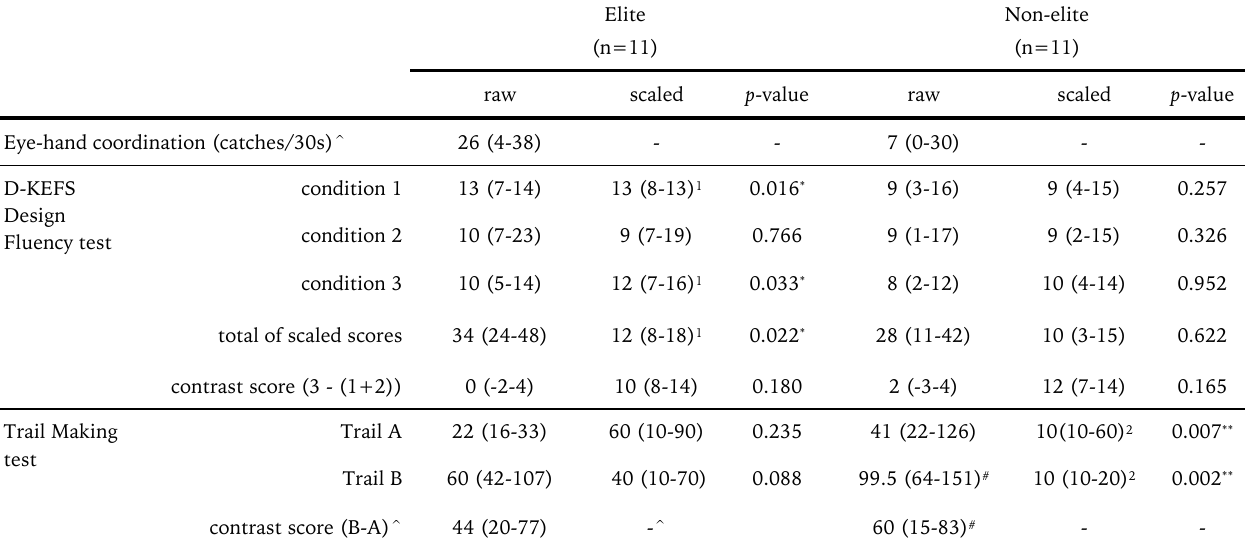
Eye-hand coordination and executive functions in para table tennis